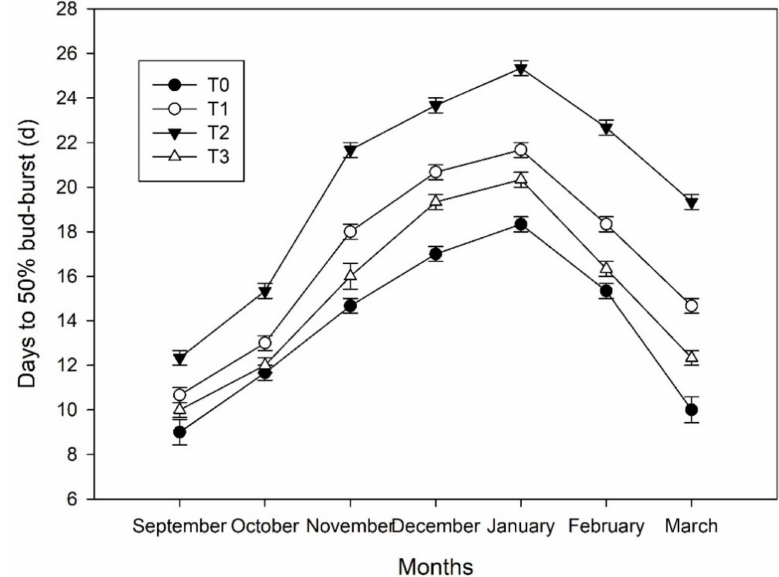
Figure5. Dynamicsofthebuddormancylevelin Magnoliawufengensis